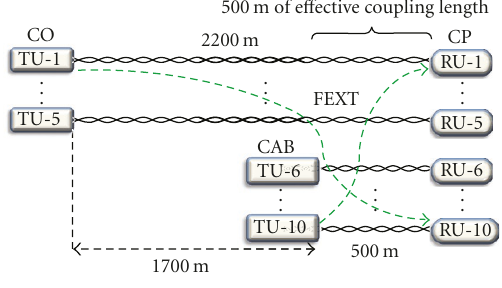
Figure 7: Access network Scenario II .